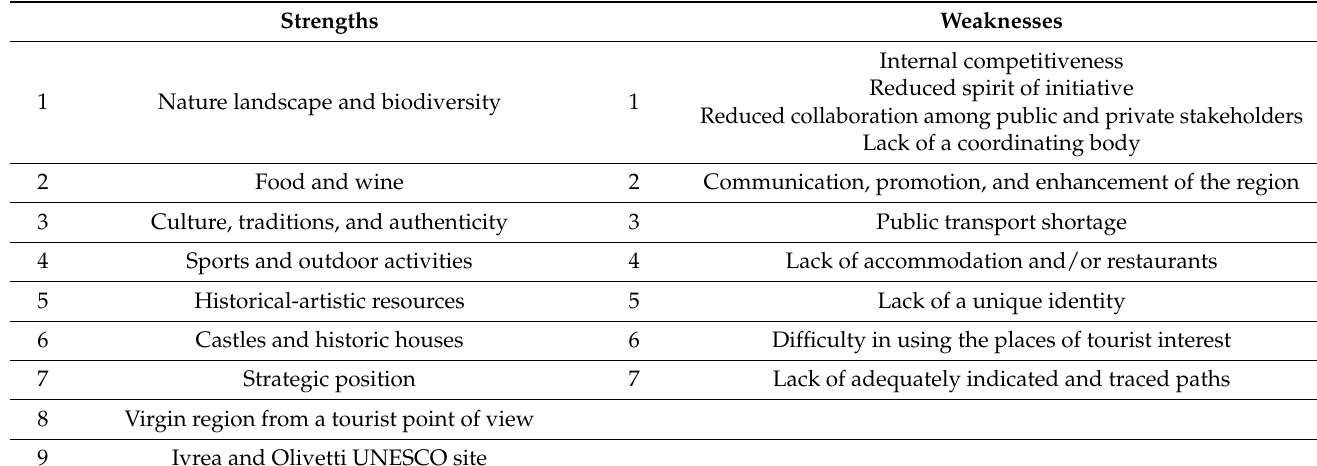
Table 3. Strengths and weaknesses of tourism in